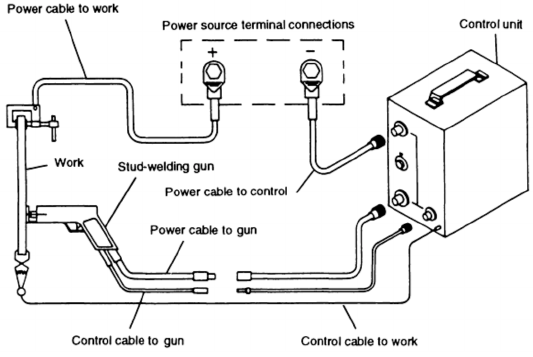
Figure 1. The schematic view of arc stud welding [3].